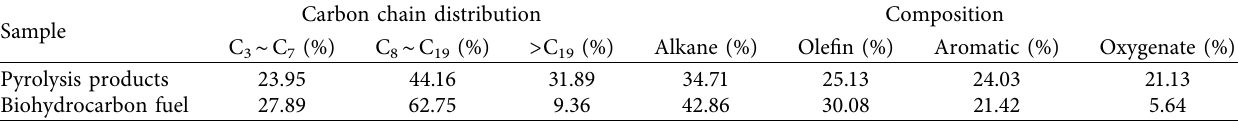
Table 6: Composition and carbon chain distribution of pyrolysis products and biohydrocarbon fuels.